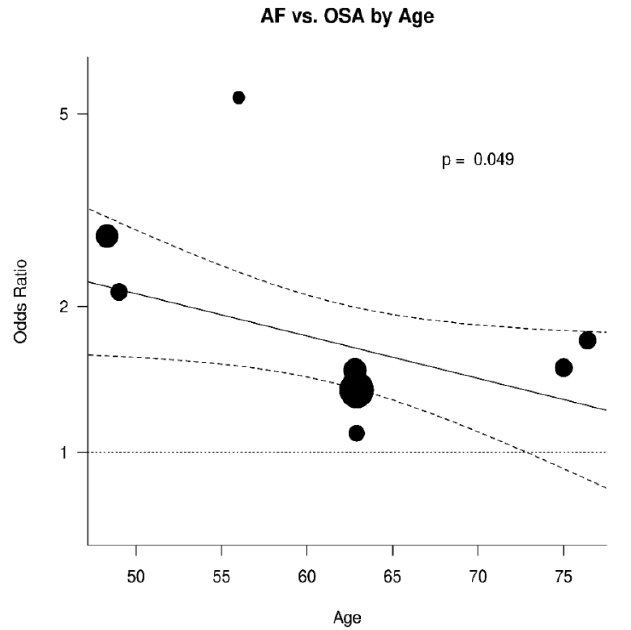
Figure 5. Effect of age in the odds ratio for atrial fibrillation (AF) in patients with obstructive sleep apnea (OSA).